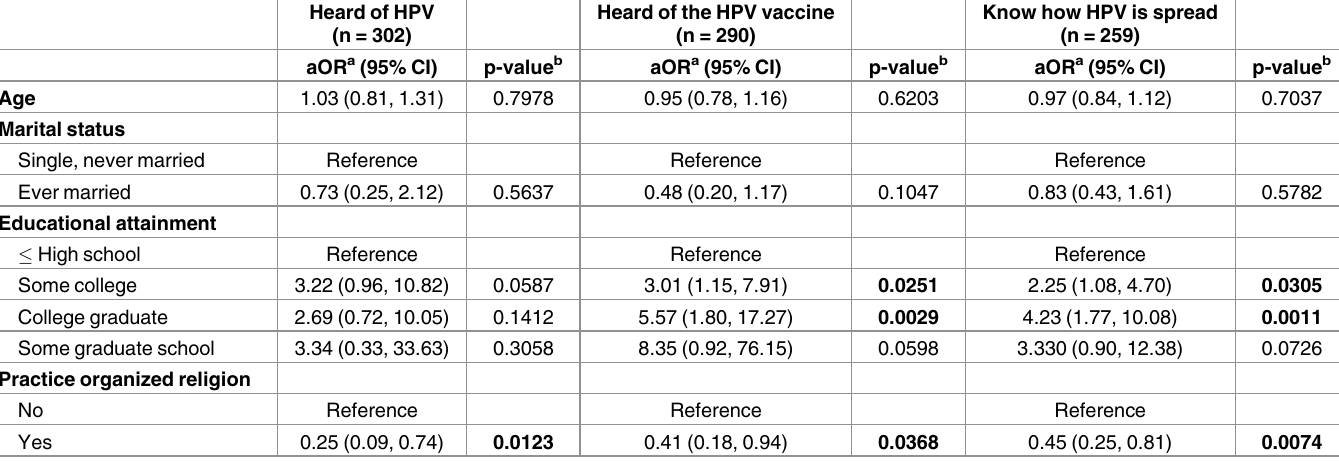
Table 3. Multivariable logistic regression for HPV vaccine-related awareness, knowledge, and beliefs.